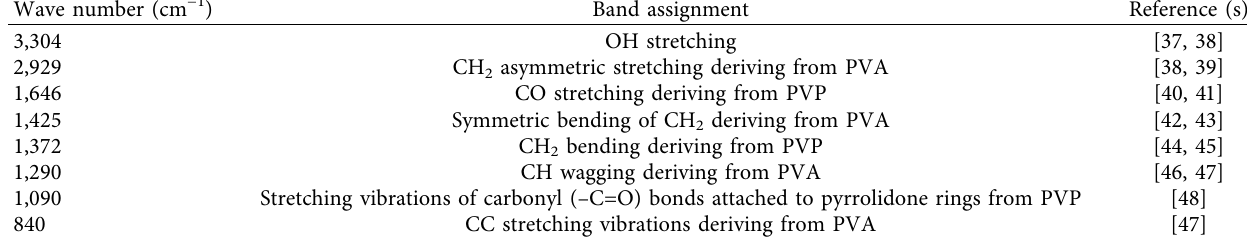
Table 1: Absorption band positions and their assignments for PVA/PVP/FeCl